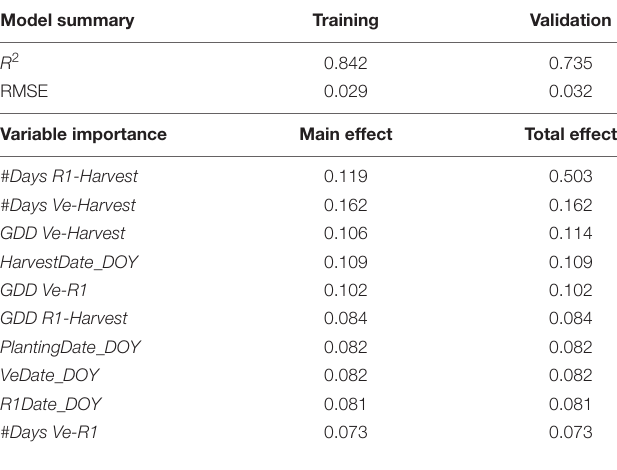
TABLE 3 | Neural Network Analysis model with NTanH(10) summary of training and validation model and variable importance assuming dependent resampled inputs for the prediction of response variable Edamame Harvest Quality Index ( EHQI ) based on phenological (Ve, emergence; R1, first flower) day-of-year (DOY), and thermal functions (GDD, growing degree days) for soybean cultivar 8080.